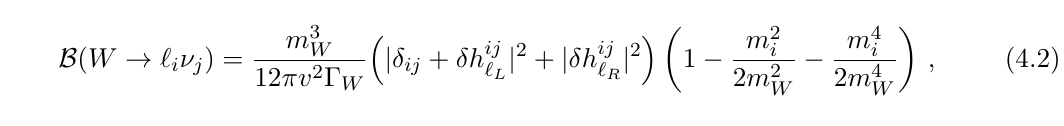
Figure 2 . Comparison of the full expressions given in eq. (3.12) and (3.13) for Z (cid:23) (cid:22) (cid:23) with the ones obtained by employing a RGE approach with a leading logarithmic